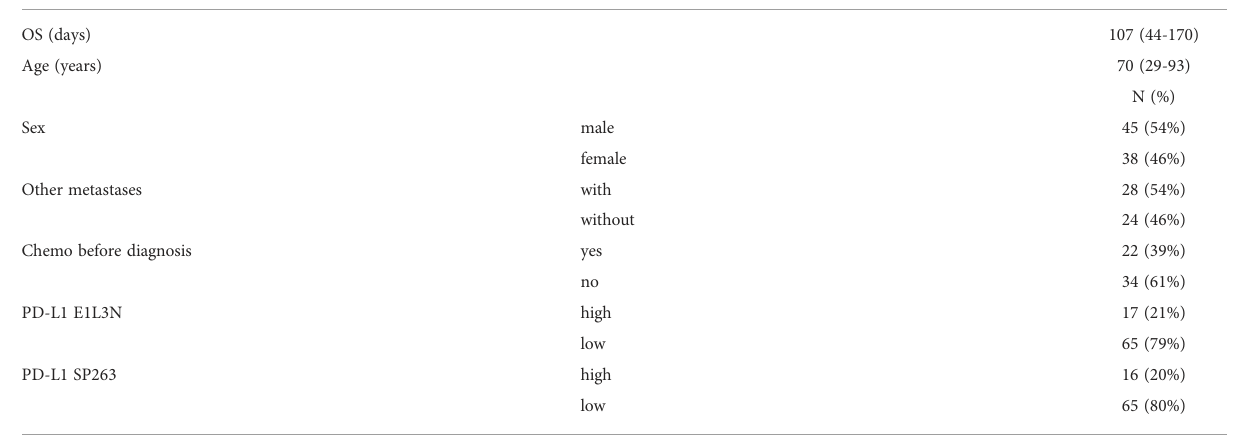
TABLE 1 Cohort description and PD-L1